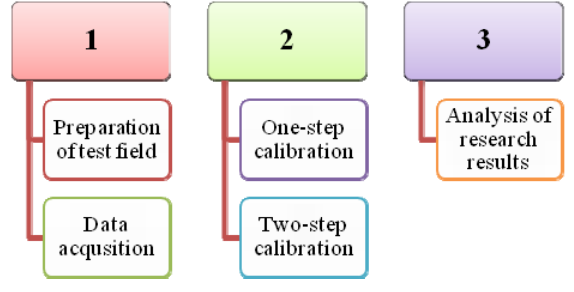
Figure 3. Steps of the research